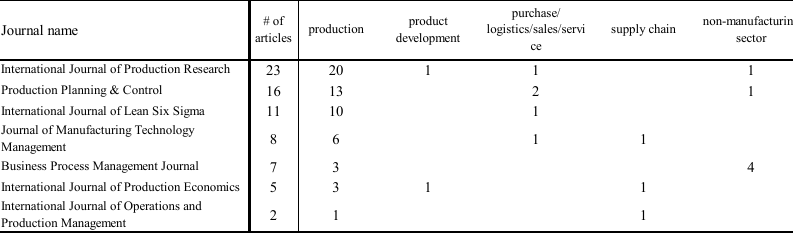
Table 2. Distribution of application of empirical VSM